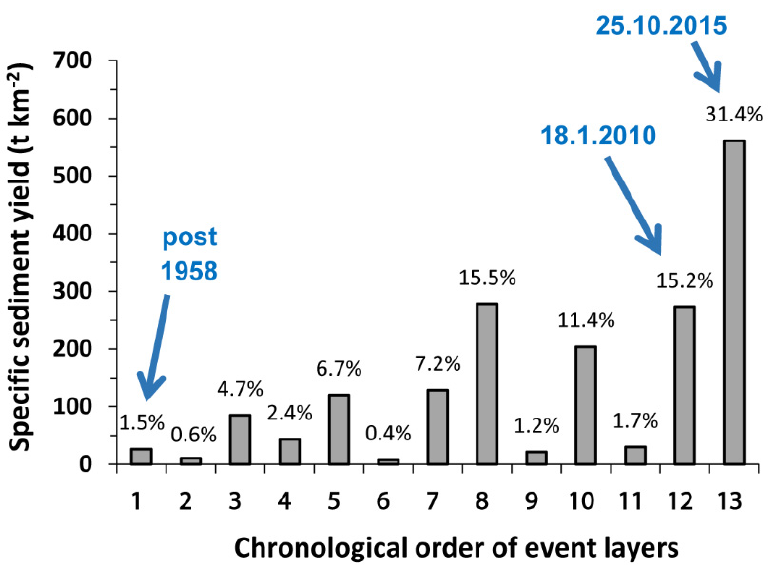
Figure 7. Specific event sediment yield of the identified event layers. The proportion (%) of each event yield relative to total historical yield appears above the columns.